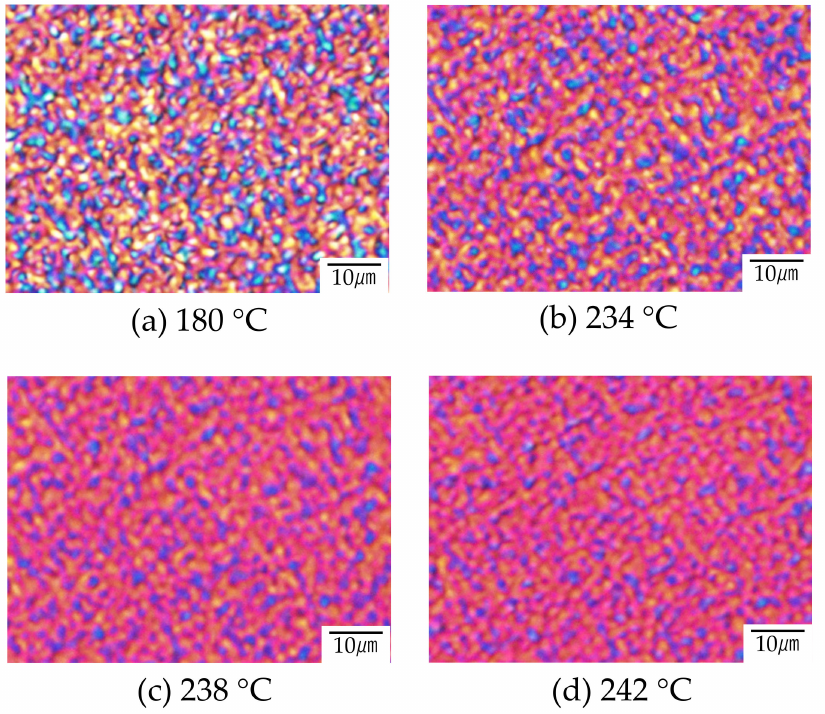
Figure 11. Polarized optical micrograph for the melting behavior during the heating of 60 / 40 PTT / PET obtained by annealing at 180 ◦ C: ( a ) 180 ◦ C, ( b ) 234 ◦ C, ( c ) 238 ◦ C and ( d ) 242 ◦